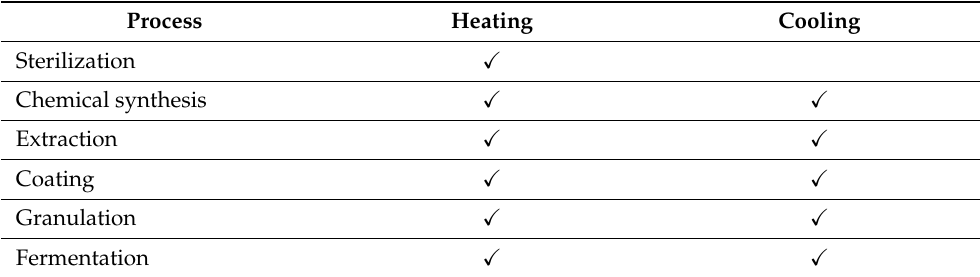
Table 6. Pharmaceutical industry process demands [107,108].